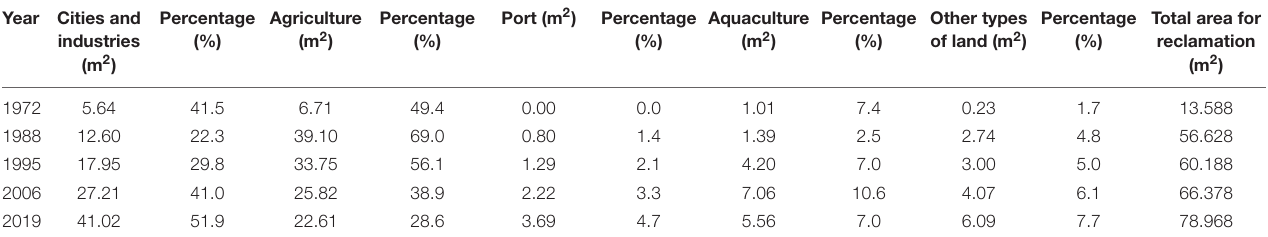
FIGURE 7 | Changes of industrial output value and correlation coefficient. (A) Annual changes in the output value of the three major industries (economy data from http://tjj.quanzhou.gov.cn/tjzl/tjsj/). (B) CHANGES of coastline parameters. (C) Area of cultivated land, shipping throughput and the number of containers, (D) Sediment transport and annual runoff variation. TABLE 6 | The proportion of different land use patterns in the reclaimed